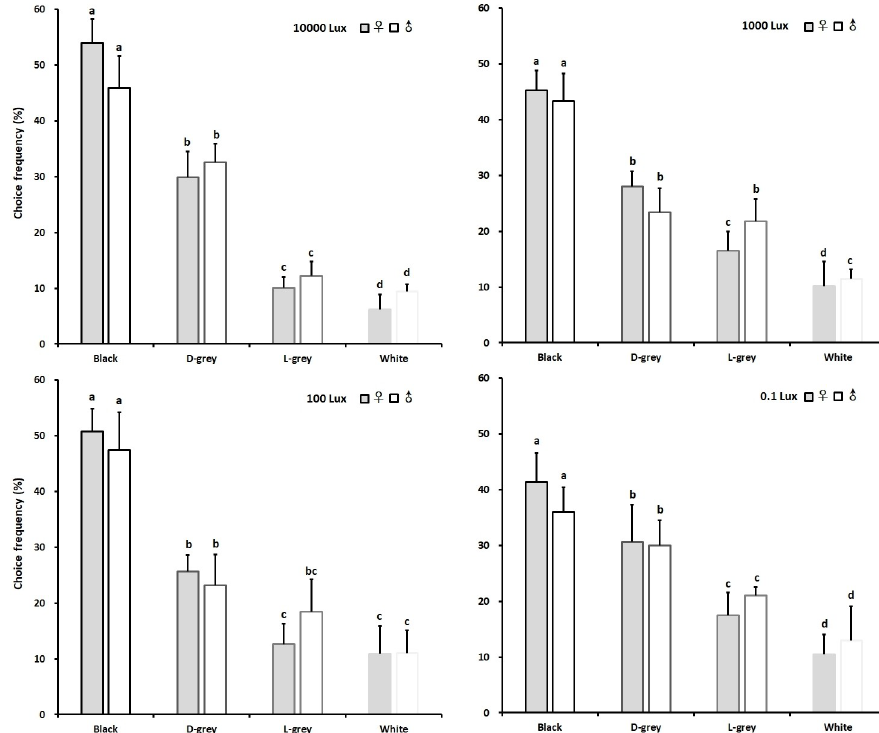
Fig 4. Colour choices of stimuli varying in brightness in chive gnat Bradysia odoriphaga adults under four different intensities of white illumination. Different letters refer to significant differences according to One-way ANOVA with P <